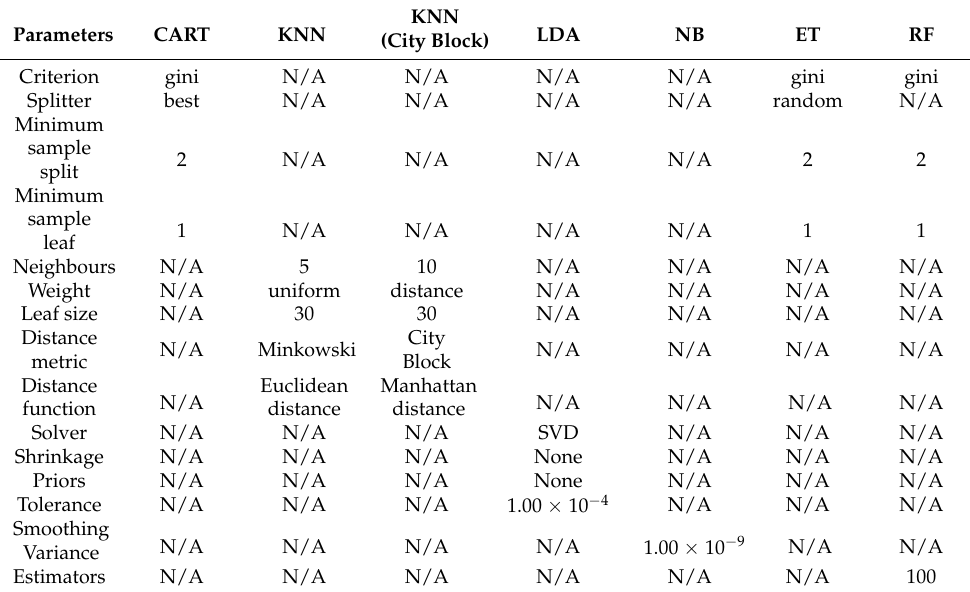
Table 2. Attributes of classification